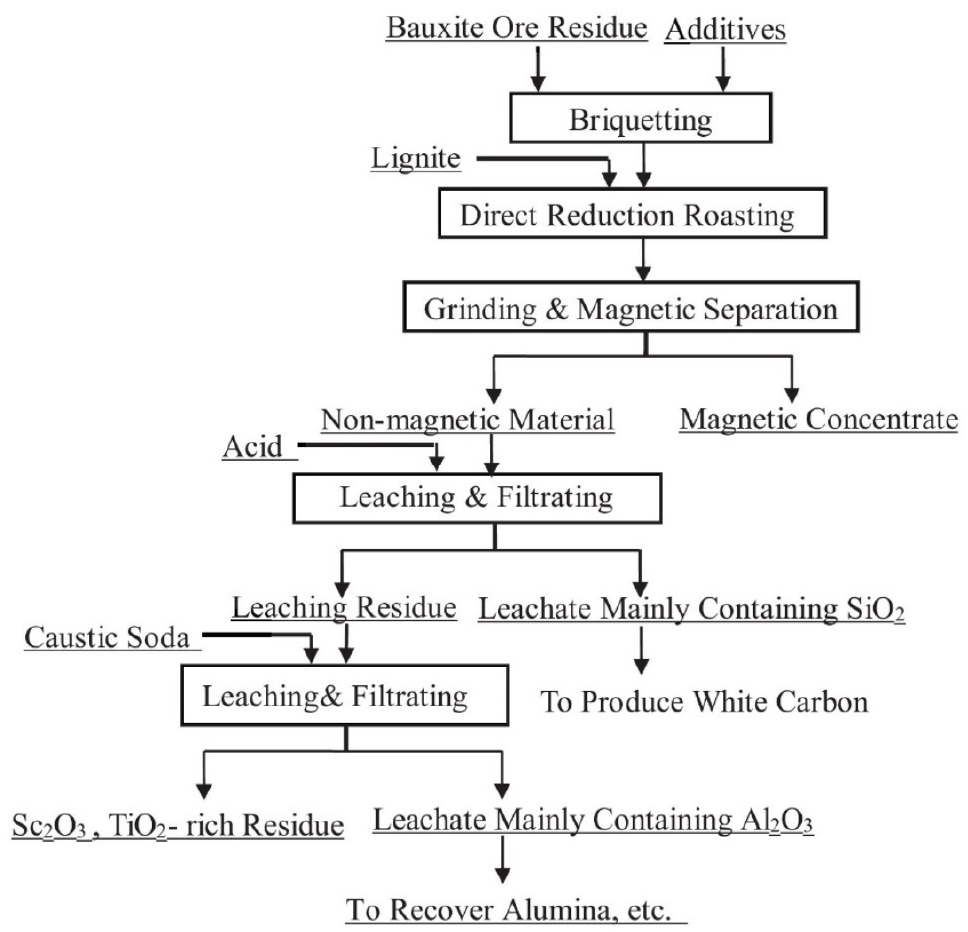
Figure 2. The schematic diagram of comprehensive processing of red mud via reduction-alkaline roasting–magnetic separation–acid leaching–pressure alkaline leaching. Reproduced from [84].